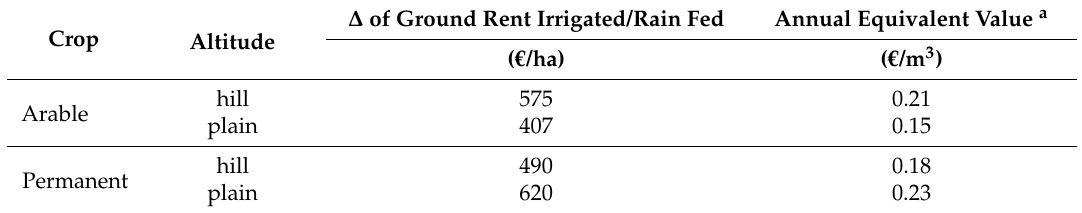
Table 6. Economic appraisal of irrigation water in the province of